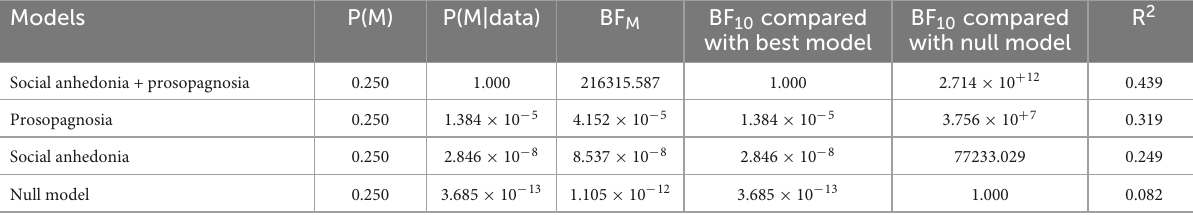
TABLE 2 Model comparison for predictors of social QATs (face matching performance and social anhedonia). Models